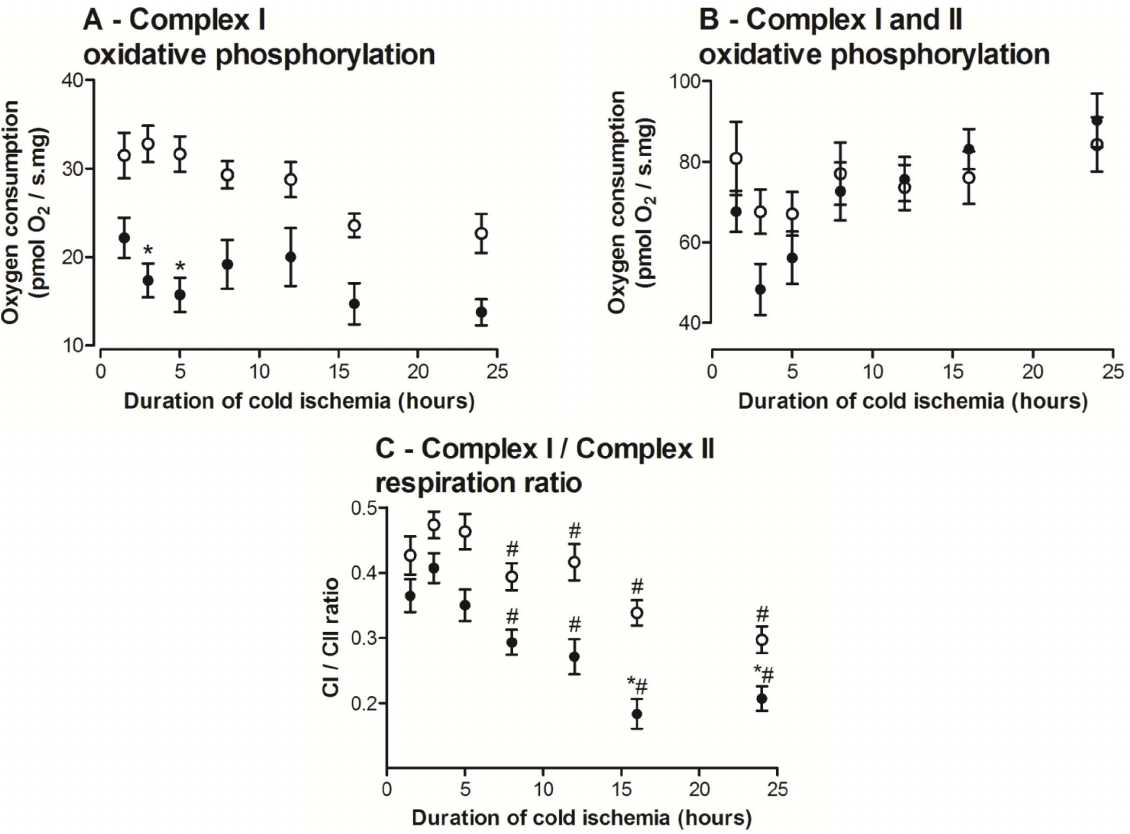
Figure 3. Mitochondrial function analysis of ob/ob and lean livers following different durations of cold ischaemia (hours). A: Ob/ob livers demonstrated lower Complex I (CI) oxidative phosphorylation throughout cold ischaemia and were significantly lower from lean livers at earlier time points. B: CI + Complex II (CII) oxidative phosphorylation did not differ between groups. C: After 8 hours of cold ischaemia, ob/ob and lean livers showed significantly lower CI respiration to CII respiration ratio compared to 3 hours of cold ischaemia. Ob/ob livers also showed significantly lower CI/CII ratios compared to lean livers after 16 hours of cold ischaemia. Data are shown as mean 6 SEM (n=9 mice/group; ob/ob , closed circle; lean livers, open circle). Restricted maximum likelihood with post-hoc Tukey-Kramer analysis was performed. *, P , 0.05 (vs. lean); # , P , 0.05 (vs. 3 hours).